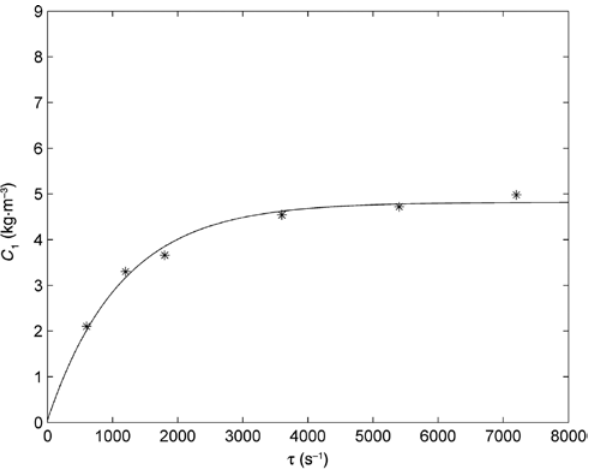
for System II at eff